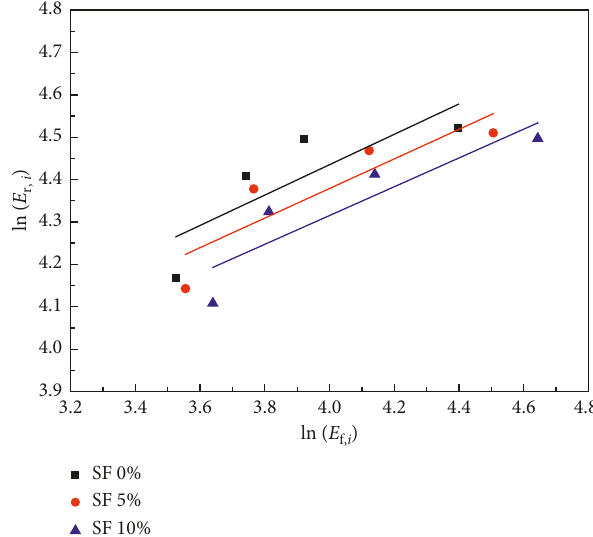
Figure 11: Energy absorption capacities of the concretes.